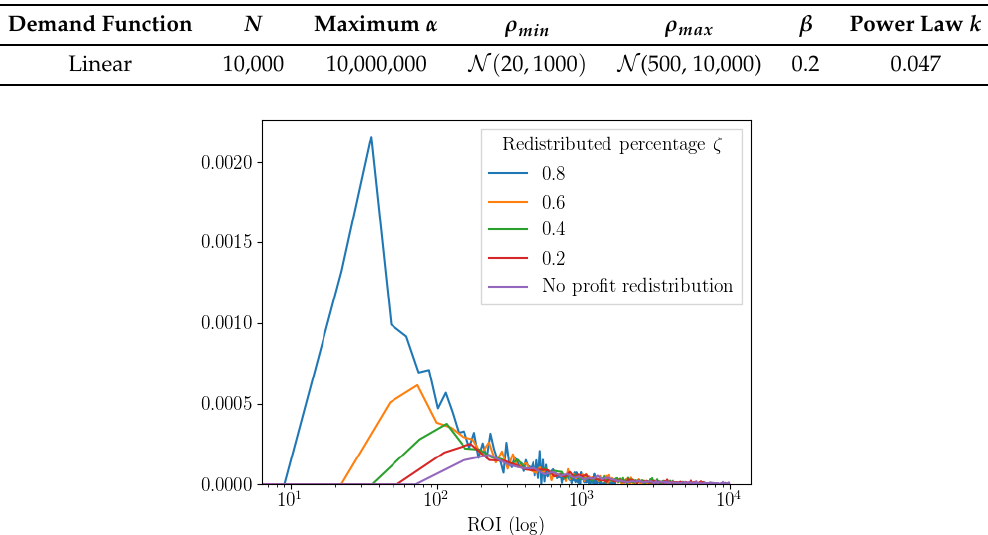
Table 1. Dataset parameters.